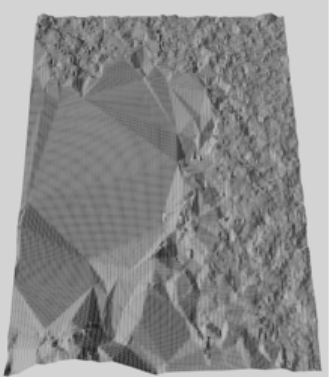
Figure 13 ADS-DSM "cloud" (oblique